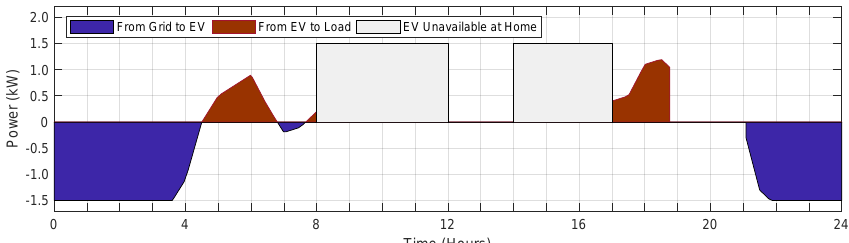
Figure 11. EV charging and discharging power profile when the proposed strategy was used for managing the energy in a smart home equipped with EV without PV.